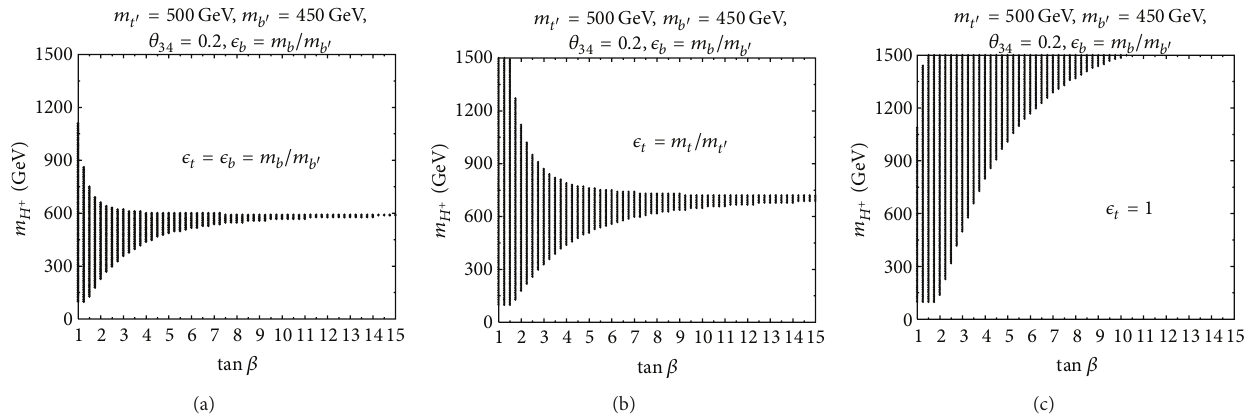
Figure 5: Allowed area in the 𝑚 𝐻 + − tan 𝛽 in the 4G2HDMI, subject to the 𝑅 𝑏 measurement (within 2𝜎 ), for 𝑚 𝑡 󸀠 = 500 GeV, 𝑚 𝑏 󸀠 = 450 GeV, = 0.2 , and 𝜖 = 𝑚 /𝑚 𝜃 34 𝑏 𝑏 𝑏 󸀠 and for three values of the Figure taken from